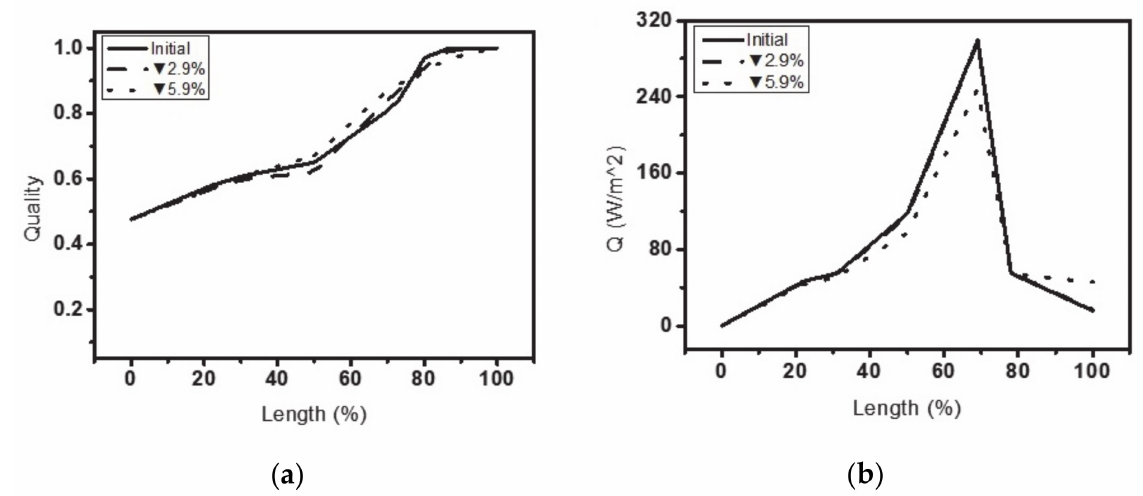
Figure 11. ( a ) quality variation with evaporator size down; ( b ) Heat transfer amount per unit area with evaporator size